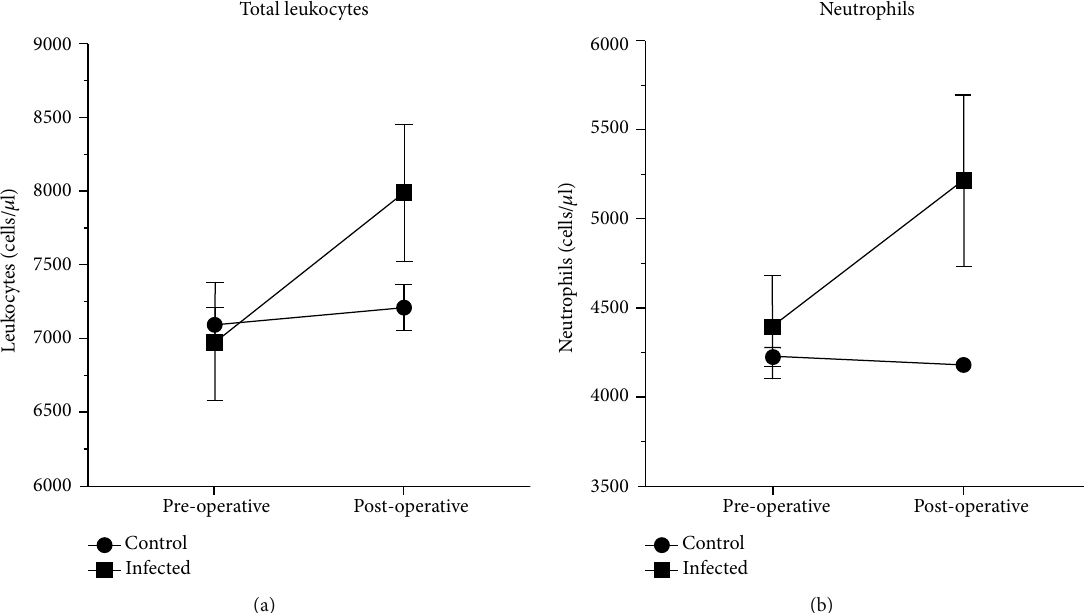
Figure 2: Change in total leucocytes (a) and neutrophils (b) in the two groups between preoperative and discharge measurements. As shown in Figure 2(a), patients who would develop infection (Figure 2(a), no squares) had a more pronounced increase in total leukocytes than uninfected subjects ( p = 0 : 006 ). This interaction still exists for neutrophil ’ s count,although it is less evident (Figure 2(b), ð p = 0 : 019 Þ .